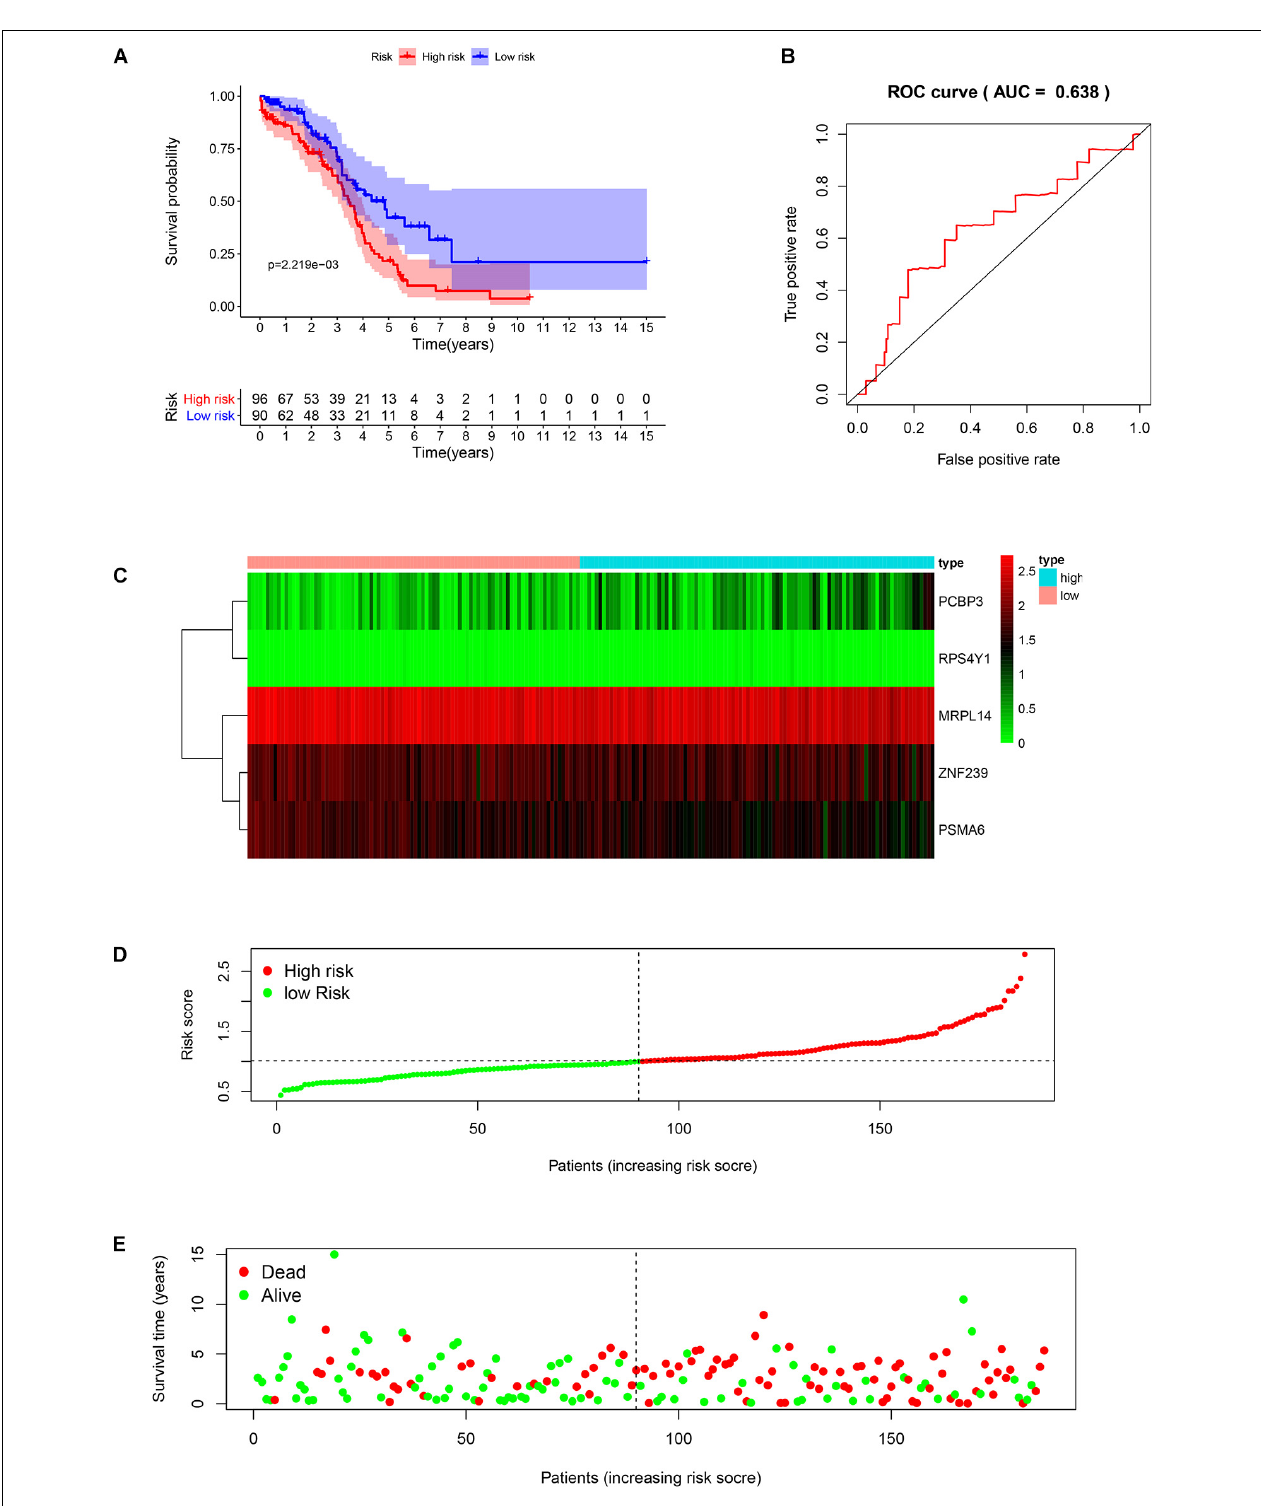
FIGURE 7 | Risk score analysis of the test cohort in TCGA using the 5-gene prognostic model. (A) Survival curve for low- and high-risk subgroups. (B) ROC curve for predicting OS based on risk score. (C) Expression heat map. (D) Risk score distribution. Patients were assigned to the training group based on risk score for determination of median risk score. (E) Survival status. The dashed line represents the median risk score; most patients on the right side had died, revealing a trend of greater risk of death with increasing risk score.